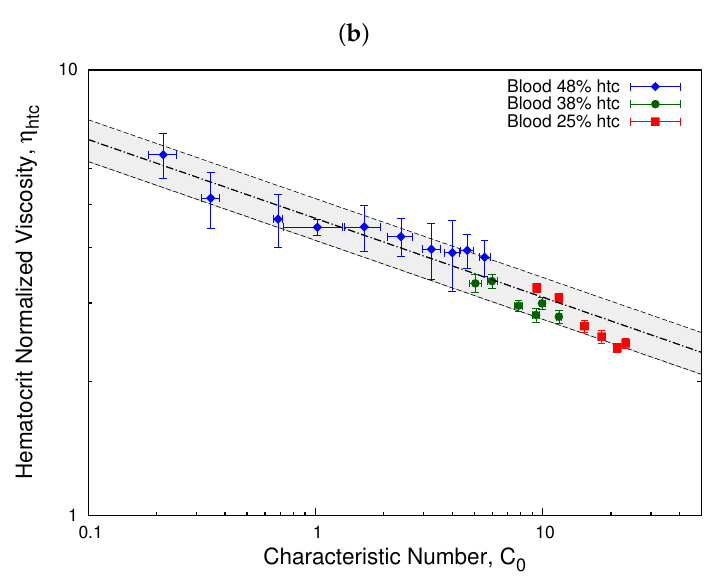
Figure 10. Hematocrit normalized viscosity vs. characteristic number. The plots show the hematocrit normalized viscosity as a function of the characteristic number, C 0 , for donors A and C as a function of the shear rate of donor B . Plot ( a ) shows the results for a linear scale and plot ( b ) for a log scale. The relations are given as κ A = 1.4 κ B and κ C = 0.6 κ B . The gray zone represents the interval where all three samples are considered part of the master curve according to its viscosity error δη = ± 0.5. The dashed-dotted line represents the fit obtained through Equation (2) for the hematocrit normalized viscosity. The value of the parameters are m = 4.64 and n =